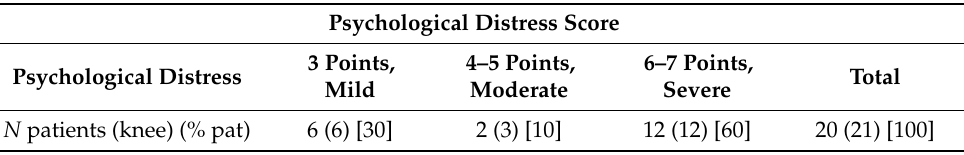
Table 3. Descriptive characteristics of the final preoperative Psychological Distress Score of hypoal- lergenic Oxinium TKA.